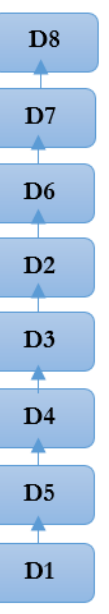
Fig. 2. ISM-based attribute